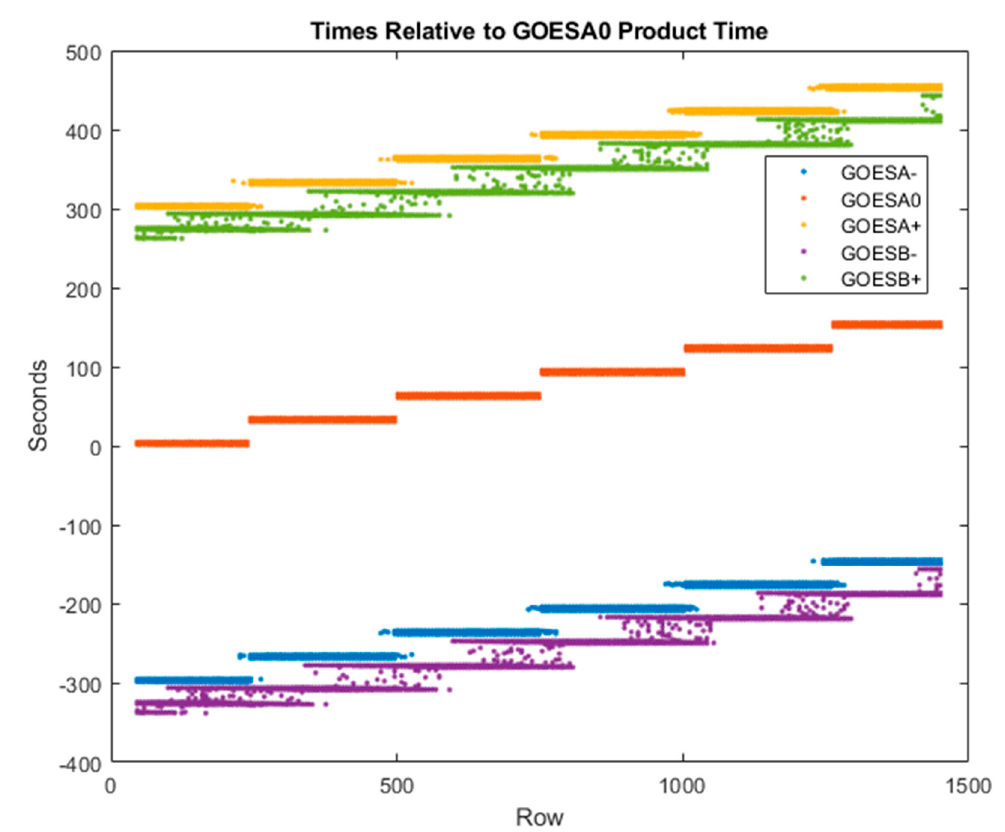
Figure 6. Assigned times for a CONUS-FD Band 14 case during Hurricane Hanna (A0 GOES-16 CONUS time: 2020 / 207 17:16Z). Time generally progresses as the row number increases from north to south. Swath transitions are evident as a staircase. The two FDs from GOES-17 fall close to the A ± CONUS repetitions from GOES-16, which are the first CONUS repetitions in their respective timelines and the A0 scene is the second repetition of the CONUS scene within its timeline.